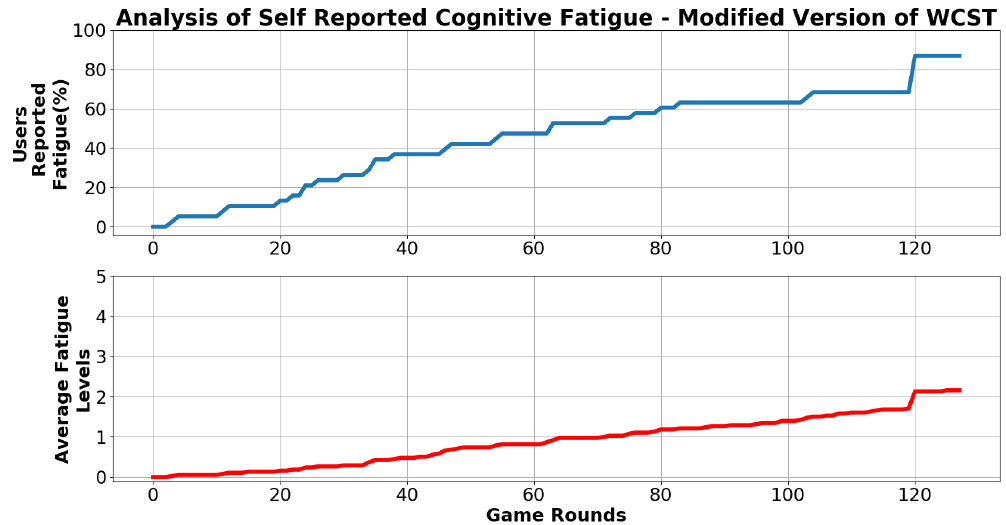
Figure 8. Analysis of Self-Reported Cognitive Fatigue during V1 and V2 versions of